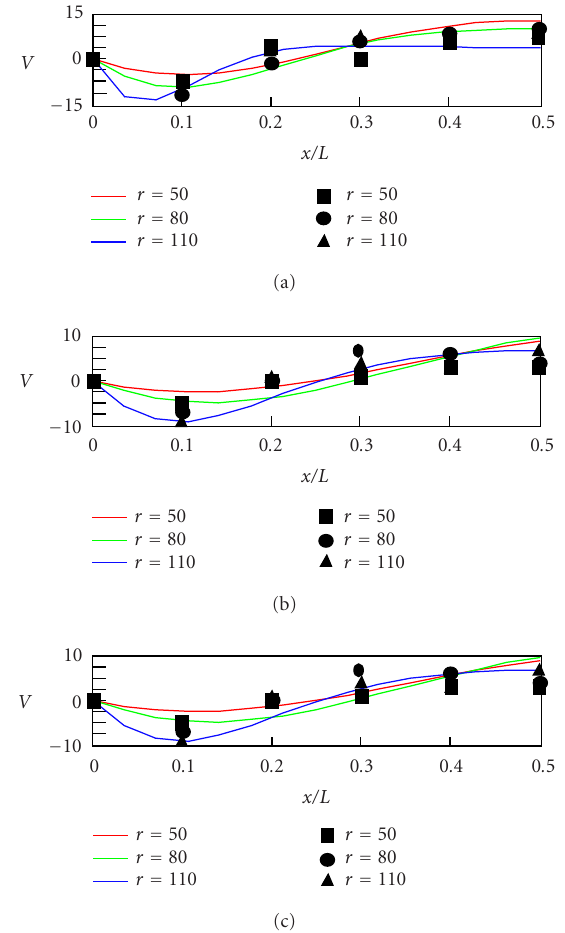
Figure 4: Velocity profiles on meridional plane in drum under spin- down process from 5s/rev to zero: (a) t = 6 seconds, (b) t = 20 seconds, and (c) t = 40 seconds (Ohue et al. [6]). Experimental data are presented by squares, circles, and triangles; prediction data by lines.